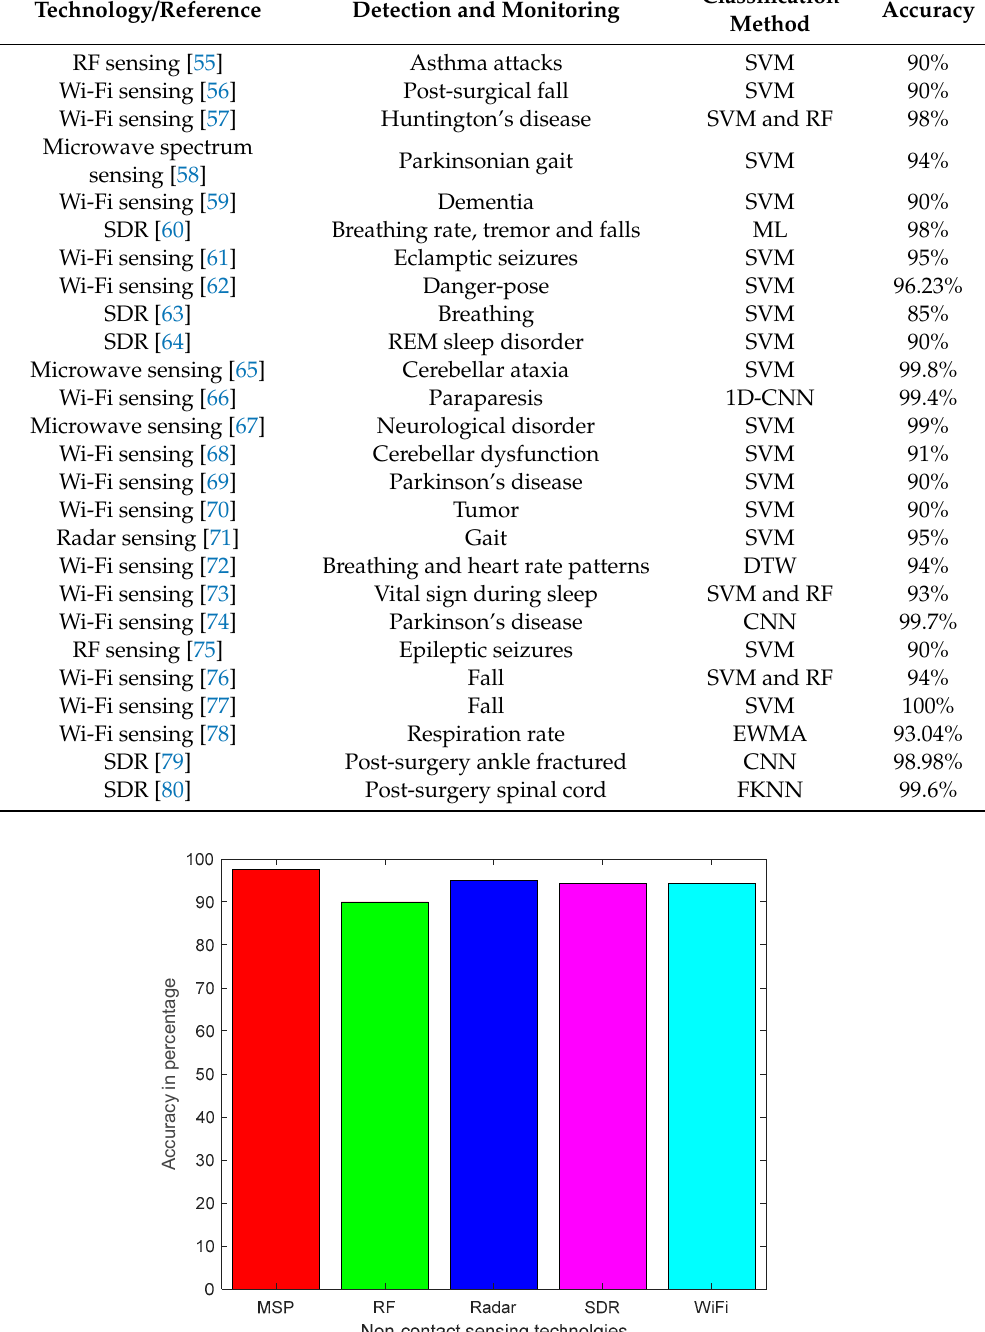
Figure 2. Average accuracy of non-contact sensing technologies for monitoring health.